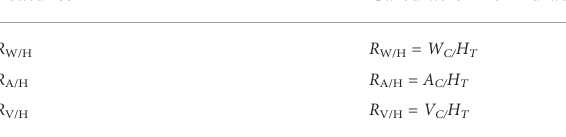
TABLE 2 Calculation of shape features.